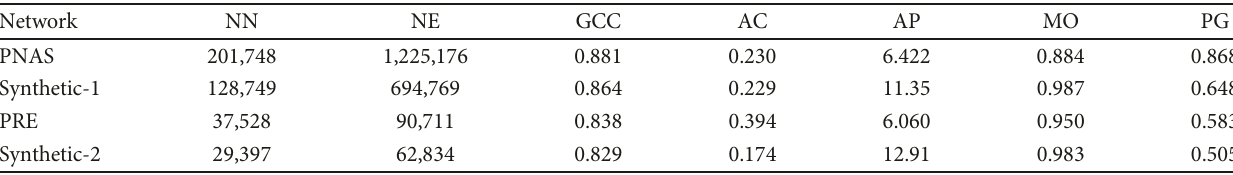
Table 3: Speci fi c statistical indexes of the analyzed networks.